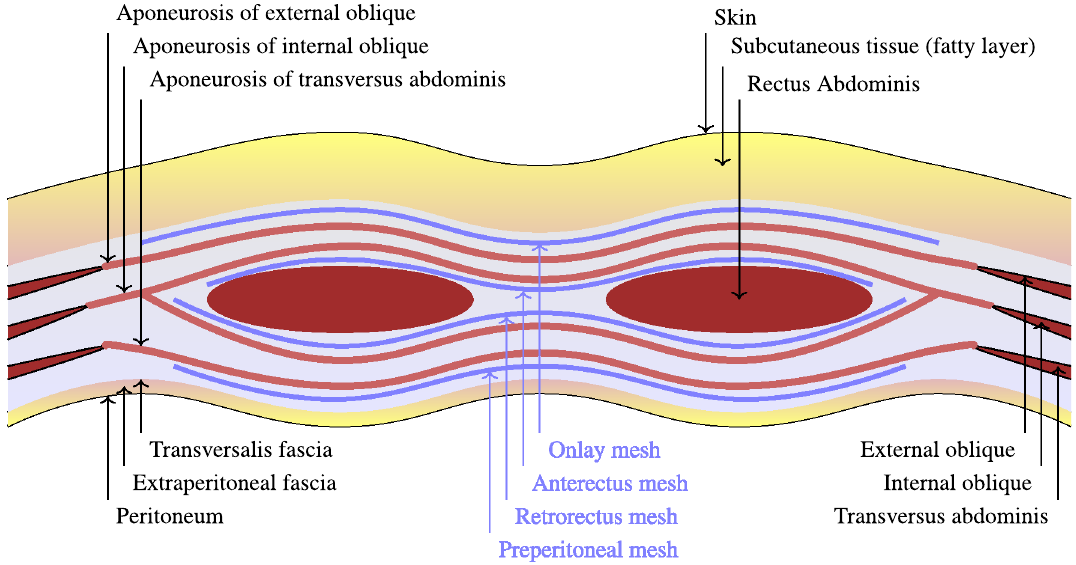
Figure 5. Mesh placements for ventral hernia repairs according to the international classification of abdominal wall planes 20